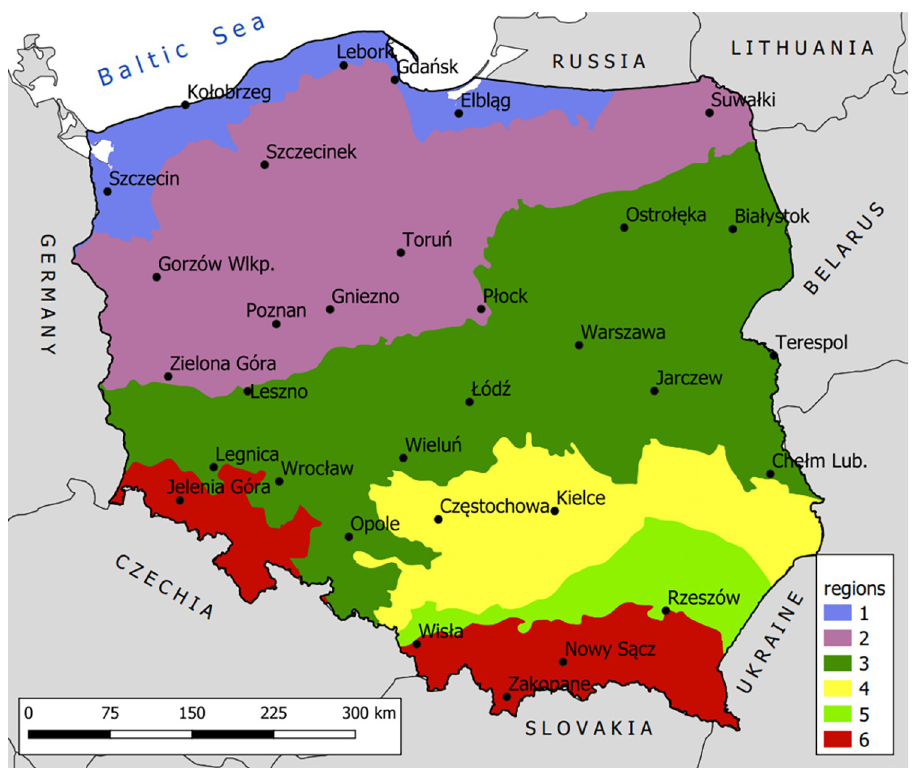
Fig 2. Location of the 32 rain gauges employed in the present study, corresponding to Polish landforms (1 –Baltic coastal lowlands, 2 –lakelands, 3 –central lowlands, 4 –uplands, 5 –sub-mountain basins, 6 –mountains).